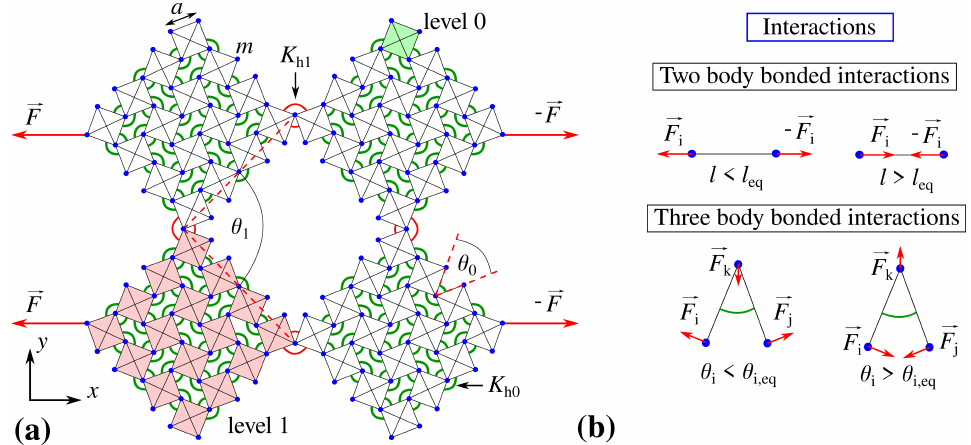
Figure 1. The panels show ( a ) an example of the analyzed system corresponding to N x × N y = 4 × 4 where red arrows indicate constant external forces applied to the leftmost and rightmost points within the system and ( b ) a graphical representation of interactions responsible for rigidity of square elements (two-body bonded interactions) and hinging between them (three-body bonded